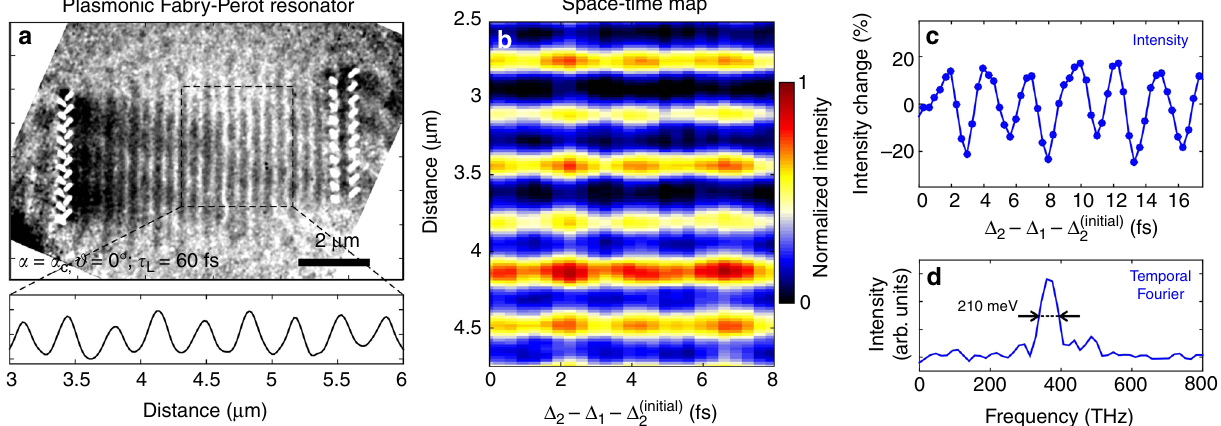
Fig. 6 Attosecond-nanometer modulation of plasmonic near- fi elds. a Energy- fi ltered image of the plasmonic interference pattern created in the designed plasmonic Fabry – Perot resonator. The tilt angles are set to ϑ = 0° and α = 12.9°, while the optical pulses are 60 fs long. b Spatiotemporal mapping of the plasmonic coherent control at attosecond-nanometer scale. c Measured temporal modulation of the plasmon-mode amplitude. d Fourier transform of the measured temporal trace